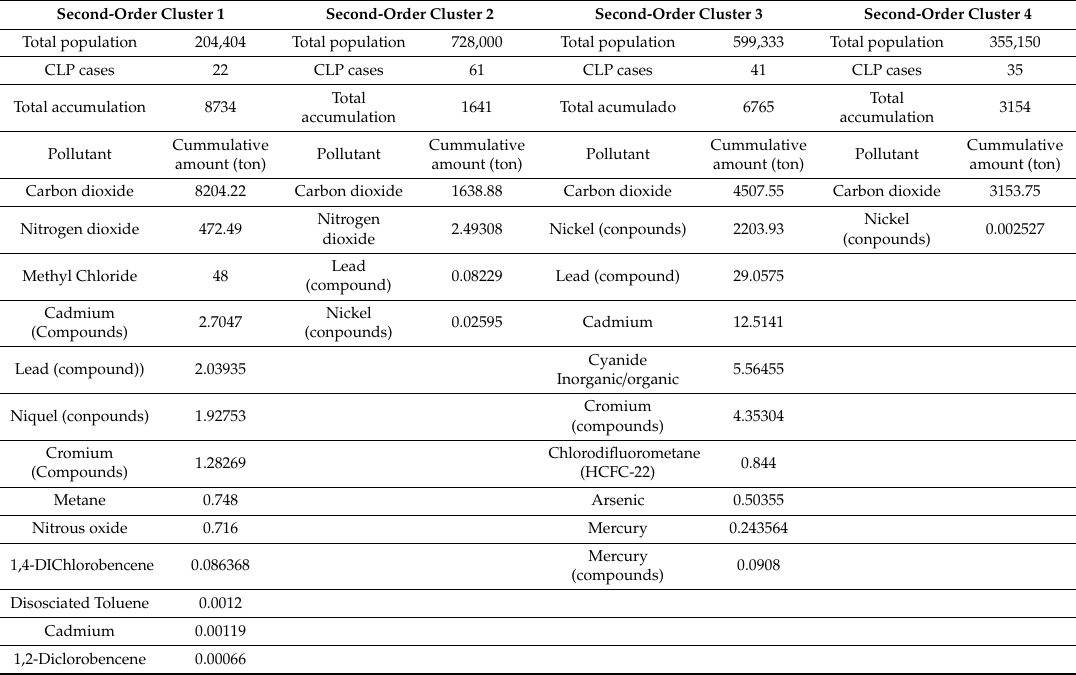
Table 3. Pollutant by cleft lip and palate (CLP) clusters.